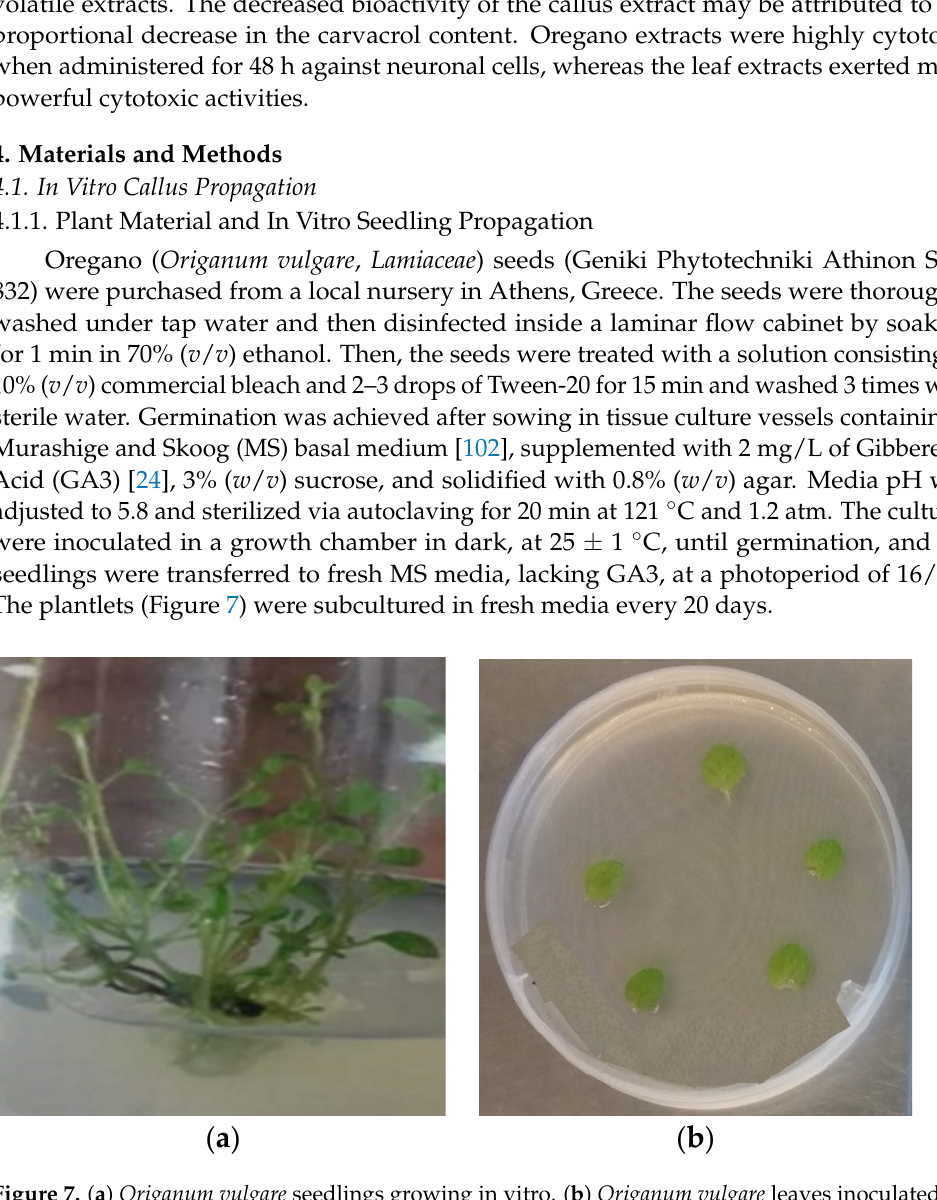
Figure 7. ( a ) Origanum vulgare seedlings growing in vitro. ( b ) Origanum vulgare leaves inoculated for callus induction.